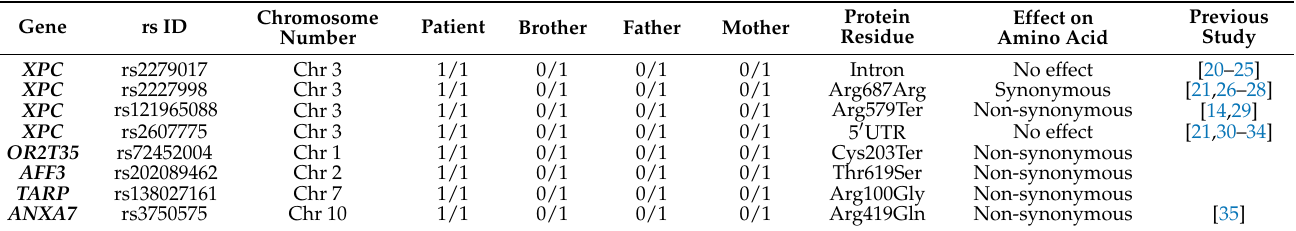
Table 1. Eight biallelic variants identified in the patient and her family members.